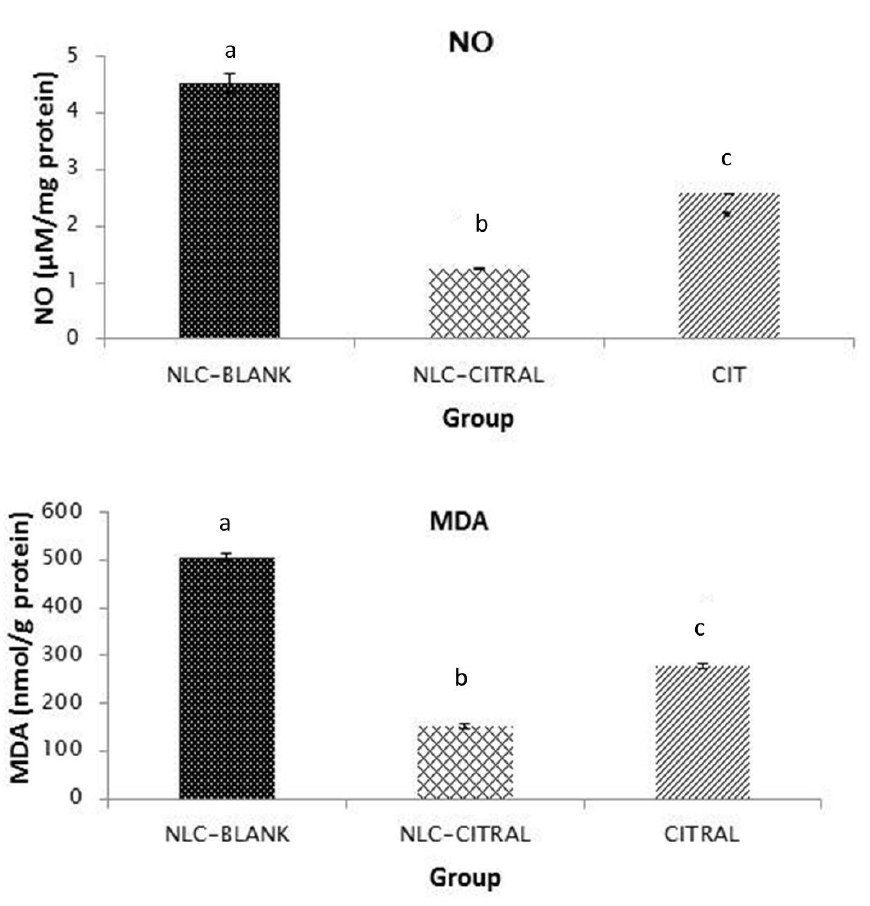
Figure 6. Nitric oxide (NO) and malondialdehyde (MDA) levels in the tumor in all groups. Each value in the bar charts is represented as mean ± SD, the experiment was performed in triplicates. Significance indicated by different alphabet was set at p < 0.05 comparing between groups.